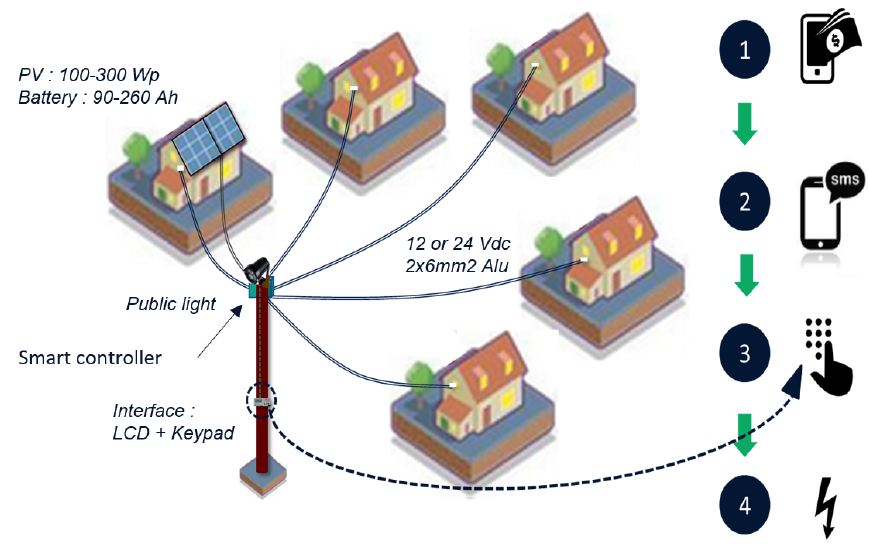
Figure 1. Schematic of a nanogrid installation.